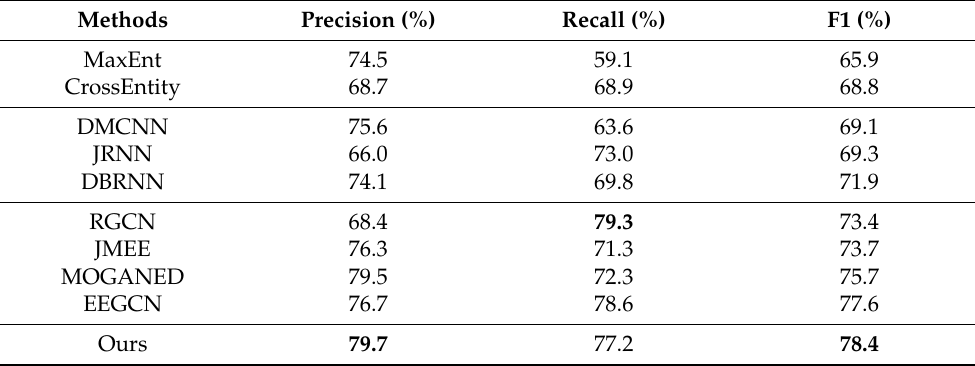
Table 2. Exploring the effect of different compatibility functions on the overall performance of the model.